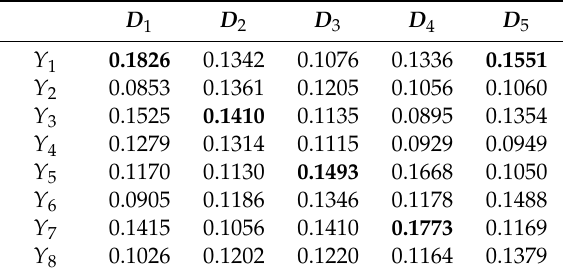
Table 5. The attribute’s weight of 5 experts.